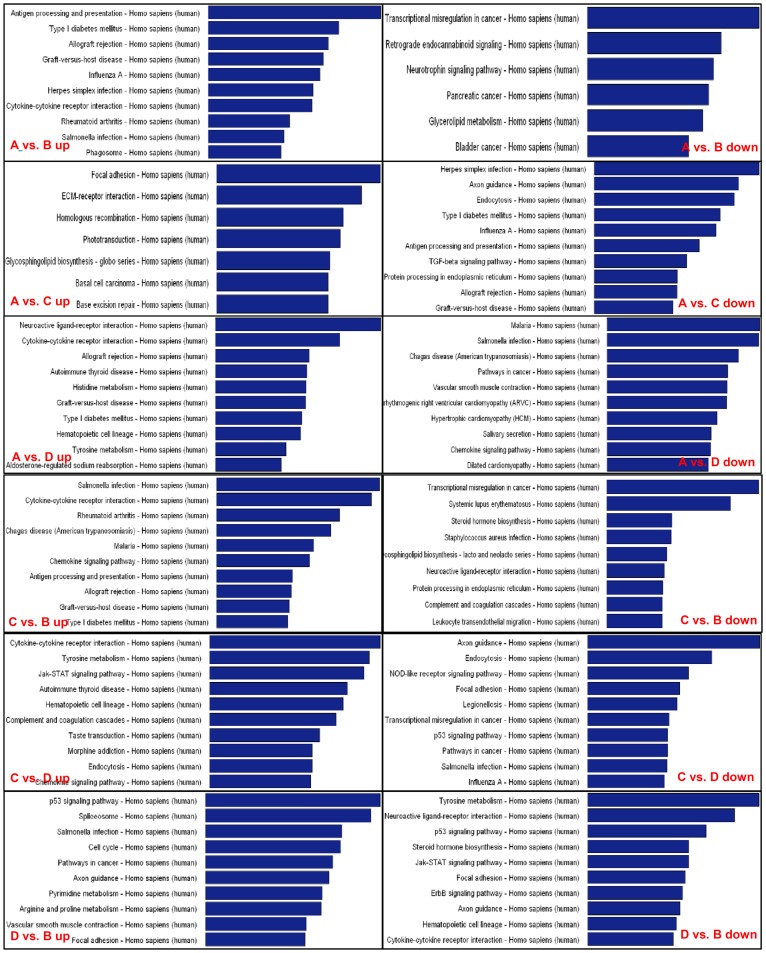
Metabolic pathways characterized from the lncRNAs differentially expressed in PPROM.Six groups of pathways (each group has up- and down-regulated) were characterized with KEGG functional analysis. Three p values, the EASE-score, Fisher-Pvalue and Hypergeometric-Pvalue were integrated for the analysis. The bar plot shows the top Enrichment Score [-log10(Pvalue)] value of the significant enrichment pathway. If there were more than 10 pathways whose Enrichment Score is >0.05, only the top 10 pathways are shown here. The higher Enrichment Score indicates the more lncRNA molecules are involved in this pathway.